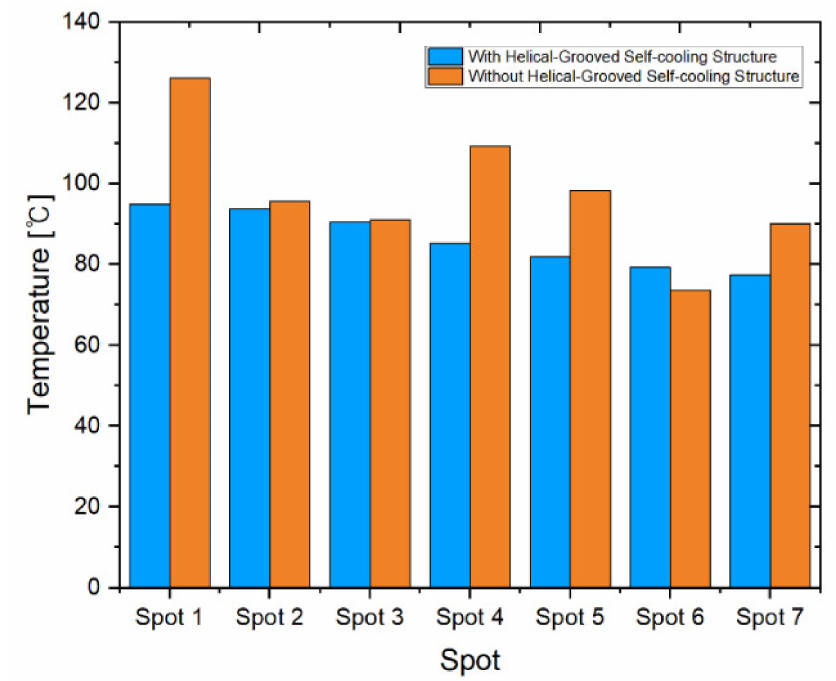
Figure 12. Temperature comparison graph for each spot at 15